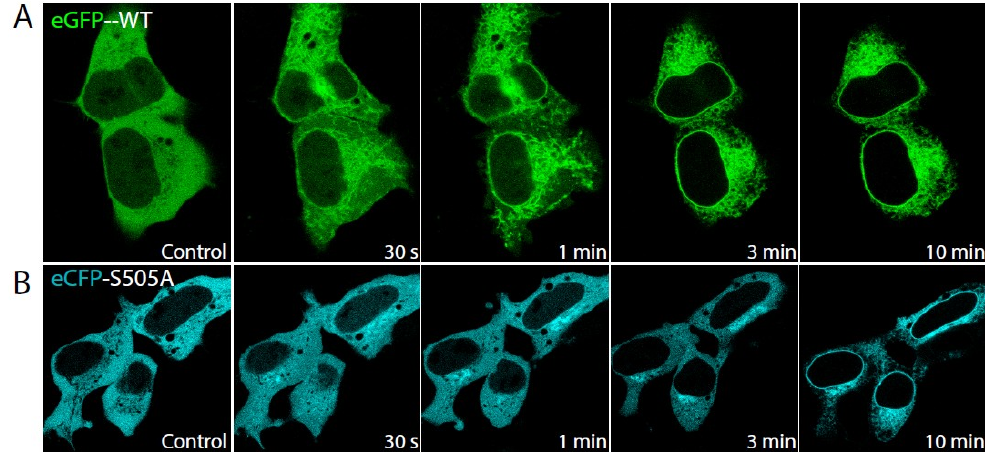
translocate to its target membranes even at high intracellular Ca 2+ levels.